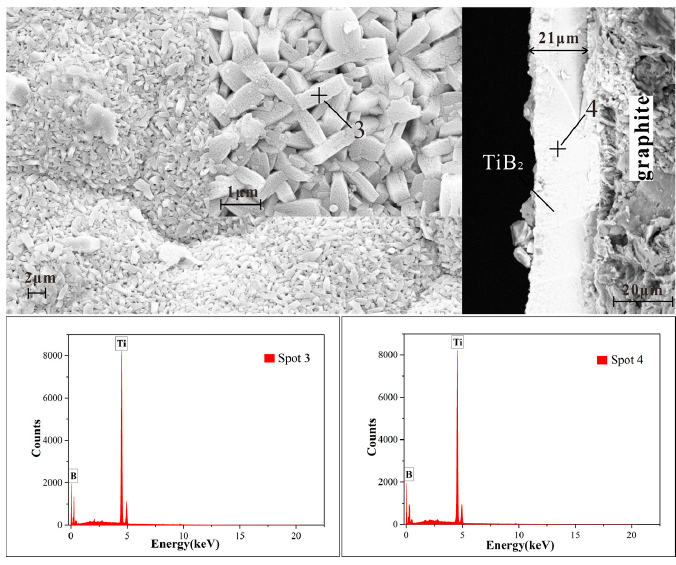
Figure 4. SEM images and EDS results of the surface and cross section of the TiB 2 film formed under the condition of a TiCl 4 /BCl 3 gas flow ratio of 1.